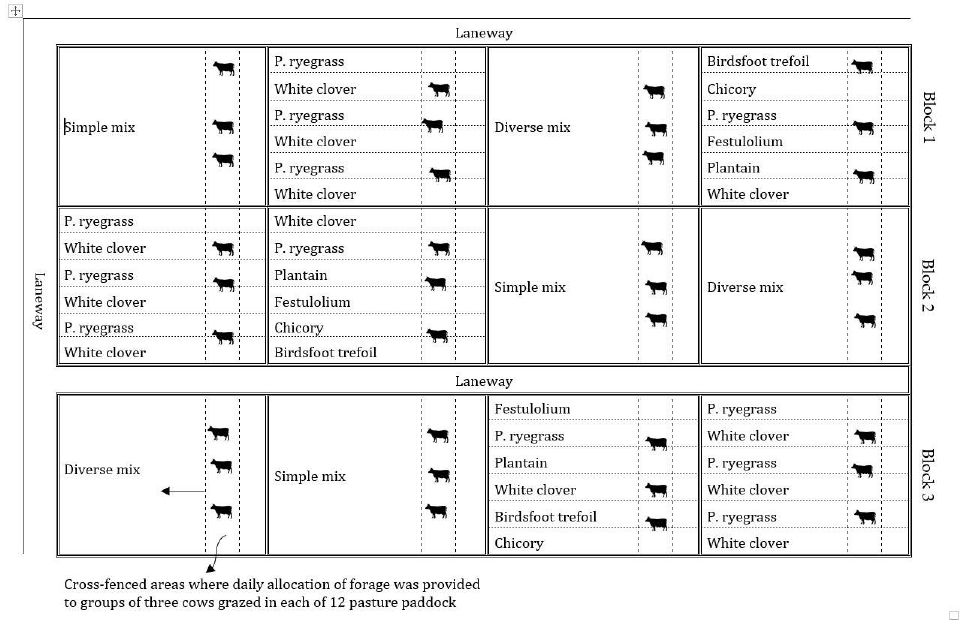
Figure 1. Diverse and simple pasture mixtures sown either as mixed or spatially separated